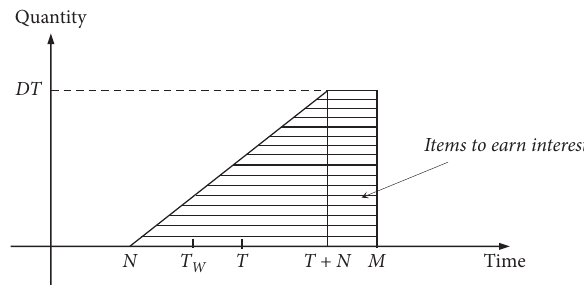
Figure 3: The earned and payable interest of the retailer when T ≤ M − N T W ≤